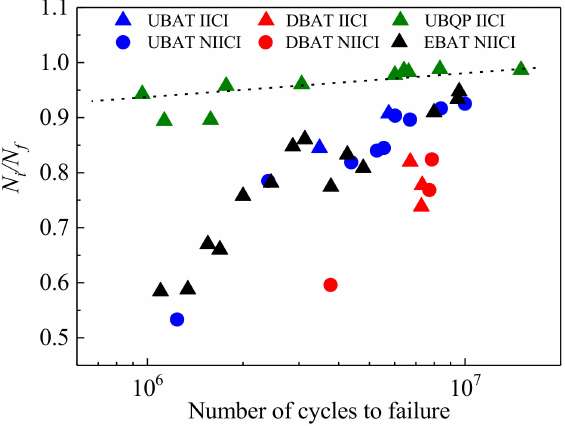
Figure 10. Normalized crack initiation life, i.e., the ratio of fatigue life due to crack initiation within FGA, as a function of total fatigue life for four bainitic steels.